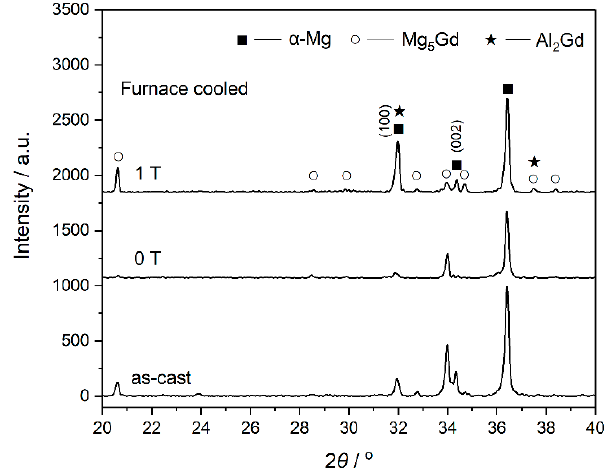
Figure 1. XRD patterns of the as-cast Mg–Al–Gd alloy and those homogenized at 620 ◦ C and furnace-cooled under 0 T and 1 T.